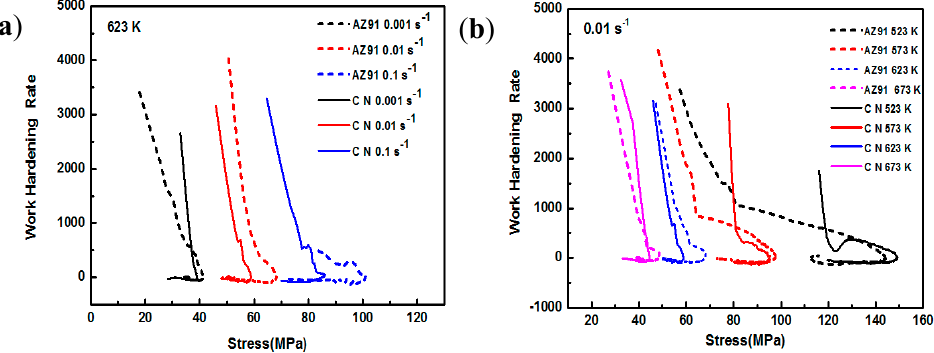
Figure 8. Schematic charts θ - σ of AZ91 alloy and nano-SiCp/AZ91 composite: ( a ) 623 K, ( b ) 0. 01 s − 1 .